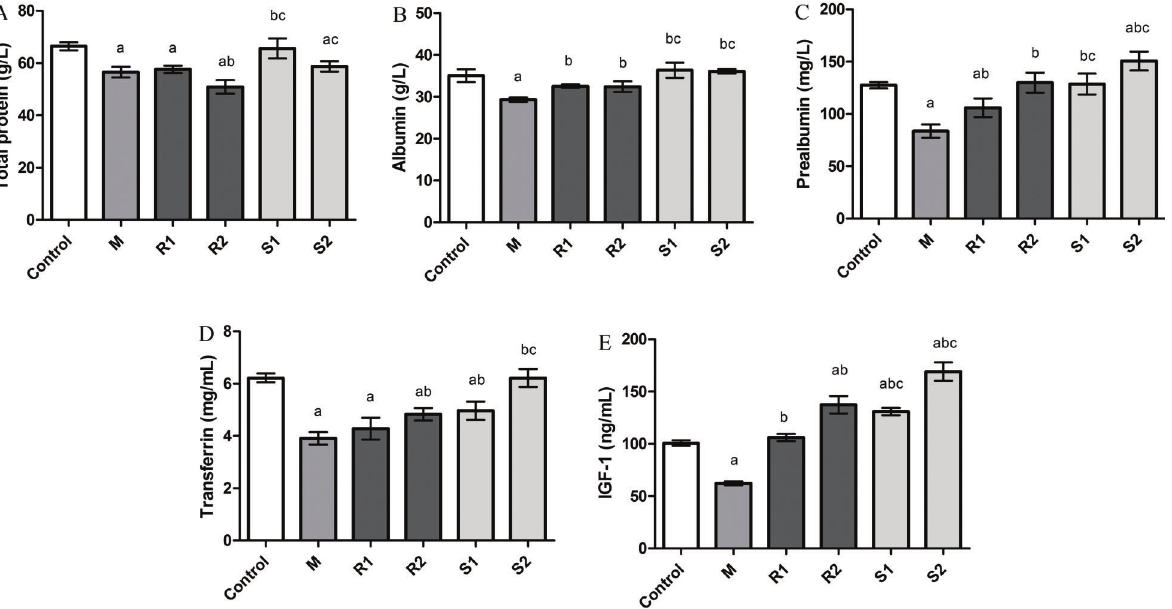
Figure 4. Levels of total protein ( A ), albumin ( B ), prealbumin ( C ), transferrin ( D ), and IGF-1 ( E ). M: intestinal obstruction group; R1: 2-day natural recovery group; R2: 4-day natural recovery group; S1: 2-day Sijunzi treated group; S2: 4-day Sijunzi treated group. Data are reported as means ± SD. a P o 0.05 compared to normal control group; b P o 0.05 compared to M; c P o 0.05 compared to R1 and R2